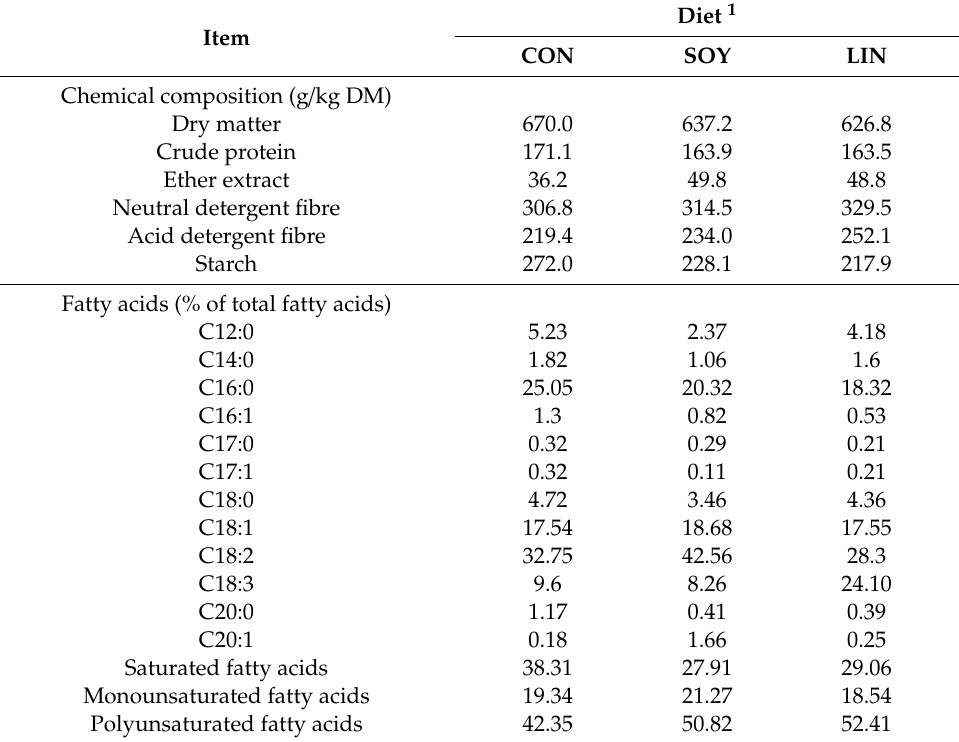
Table 2. Chemical and fatty acid composition of the experimental